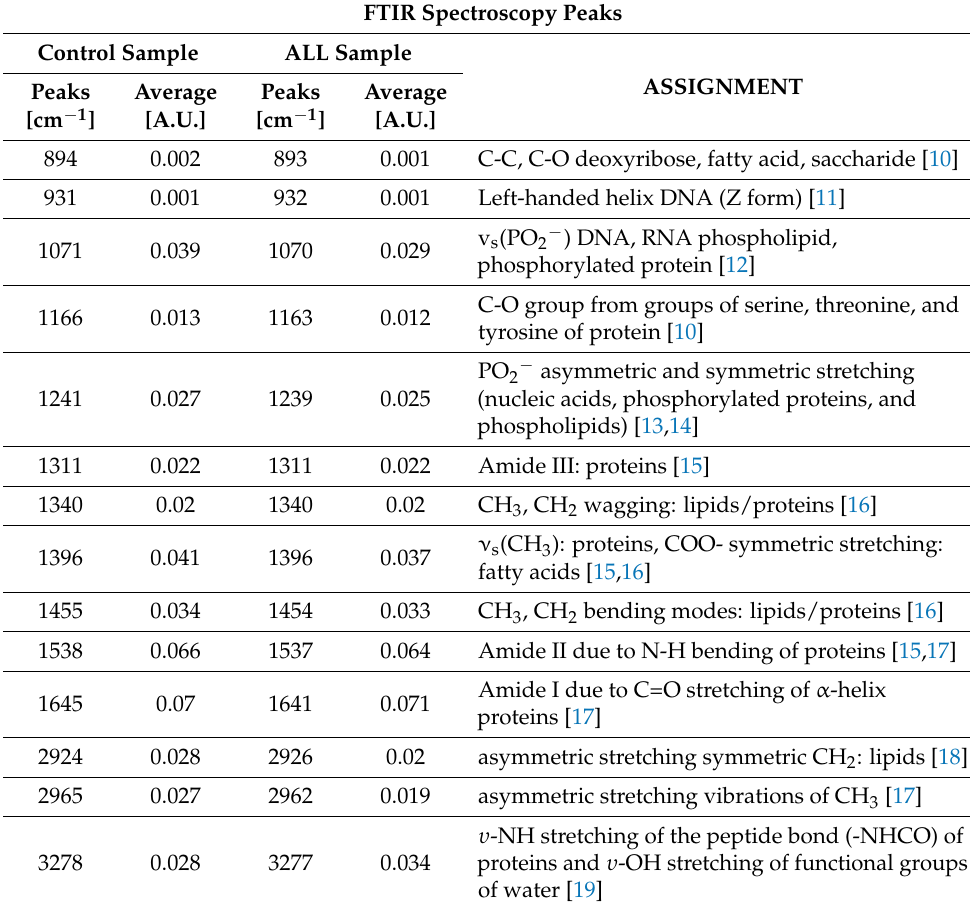
Table 1. FTIR peaks position with corresponding vibrations in the analyzed three